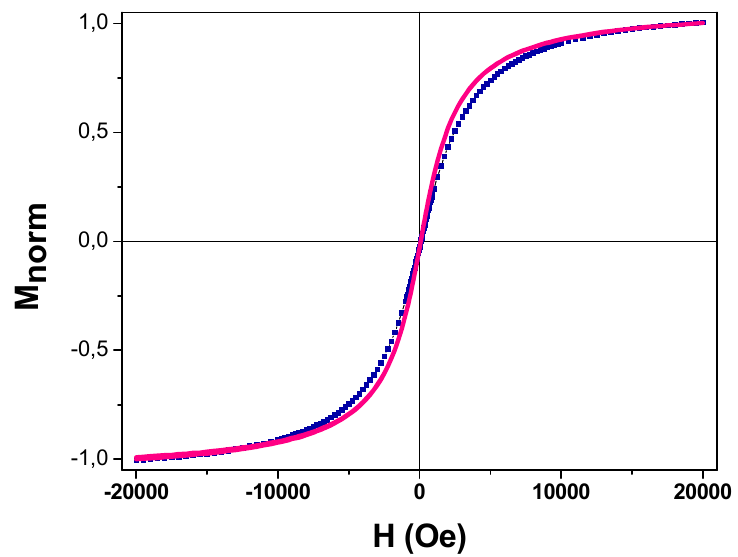
Figure 5. Variation in the normalized magnetization as a function of the magnetic field at room temperature on B@Ni ( ━ ) and B@CuNi ( ).